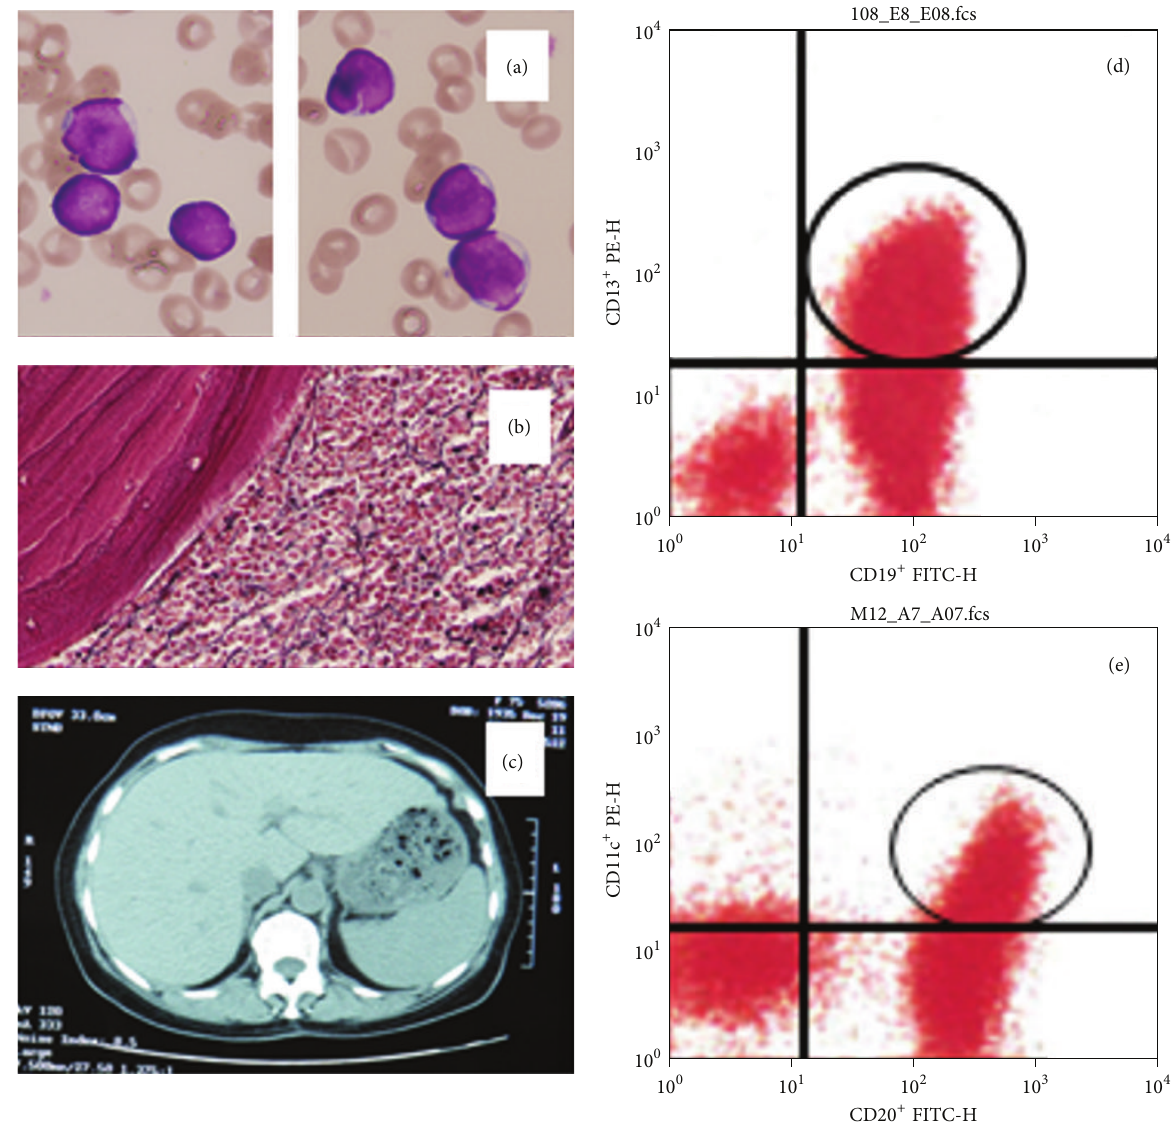
Figure 1: (a) Neoplastic lymphoid cells in the peripheral blood (original magnification × 1,000). (b) Bone marrow core biopsy specimen. BCL-2 positive cells are diffusely infiltrated ( × 200); CCND1 and EBER in lymphoma cells were negative (data not shown). (c) CT scan of the abdomen showing mild splenomegaly, (d) flow cytometry of peripheral blood showing CD19 + CD13 + neoplastic cells accounted for 64.2% (circled area), and (e) flow cytometry of peripheral blood showing CD20 + CD11c + neoplastic cells accounted for 25.1% (circled